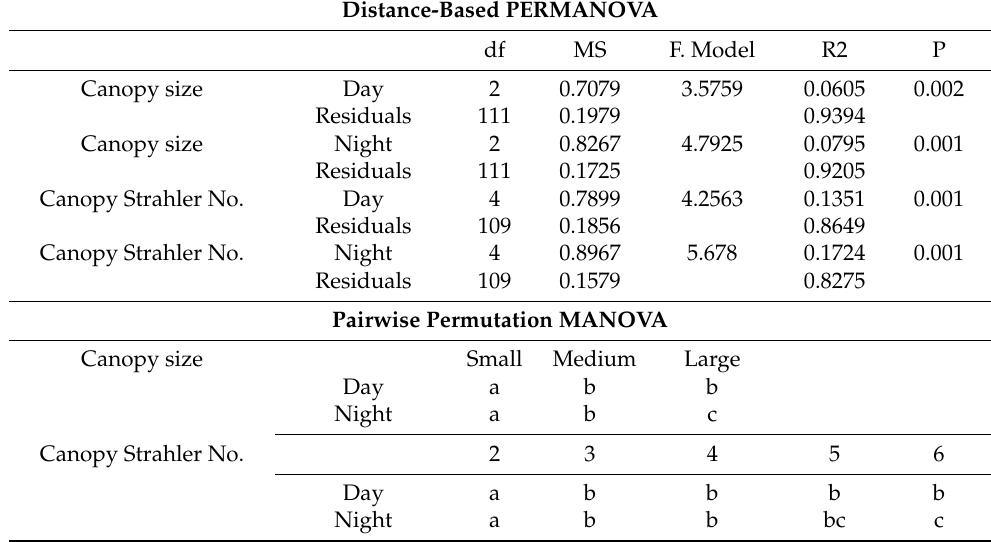
Table 2. Summary of one-way PERMANOVA and pairwise permutation MANOVA results for differences between canopy dwelling communities, performed separately for each survey (day, night) on colony size (small, medium, large) or colony Strahler numbers (2–6), based on Bray–Curtis dissimilarity and a 0.85 power transformation of canopy dwelling species abundance data. Different letters indicate significant different